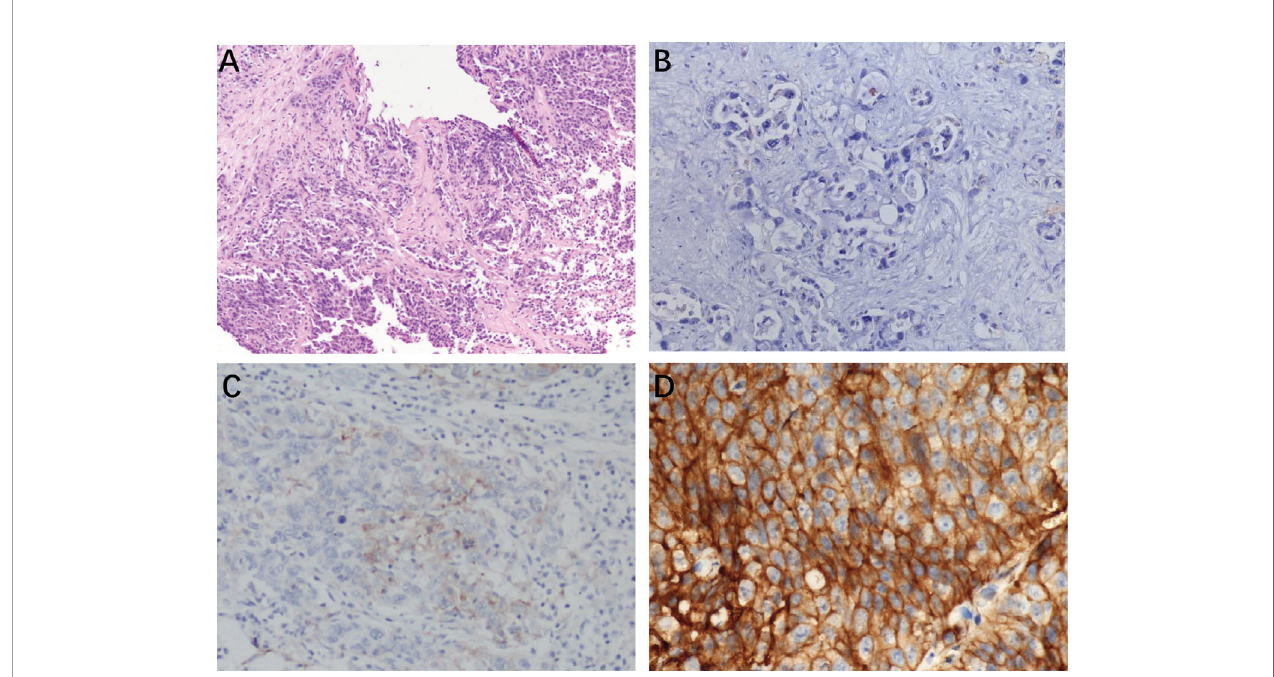
FIGURE 3 | Typical photomicrographs of PD-L1 immunohistochemistry in patents ’ archived pretreatment formalin- fi xed and paraf fi n-5 embedded tumor tissue: (A) HE staining, 100×; (B) PD-L1 negative, 200×; (C) PDL1-stained tumor cell (3%) 100×; (D) positive PD-L1 expression (50%) 400×.